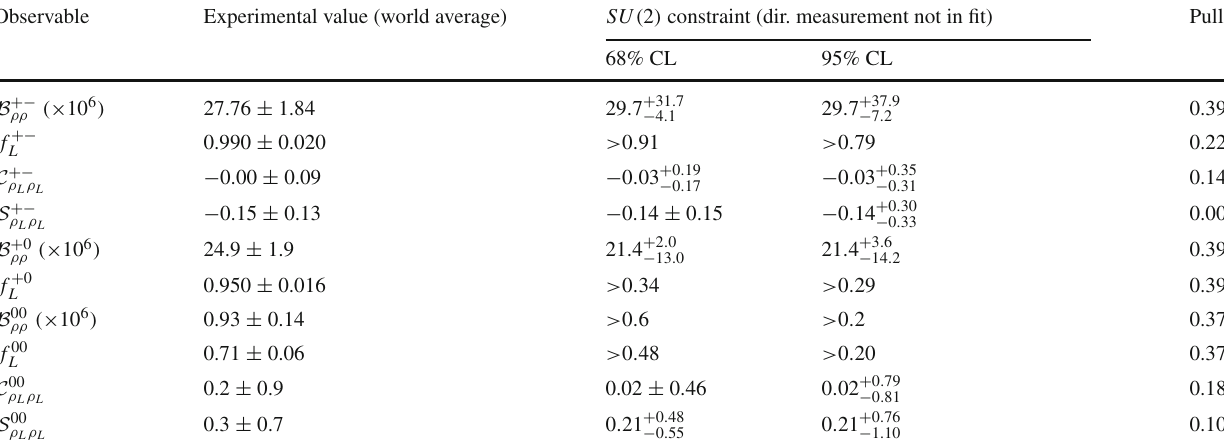
Table 15 Indirect SU ( 2 ) isospin determination of the B → ρρ observables compared to their experimental measurement Observable Experimental value (world